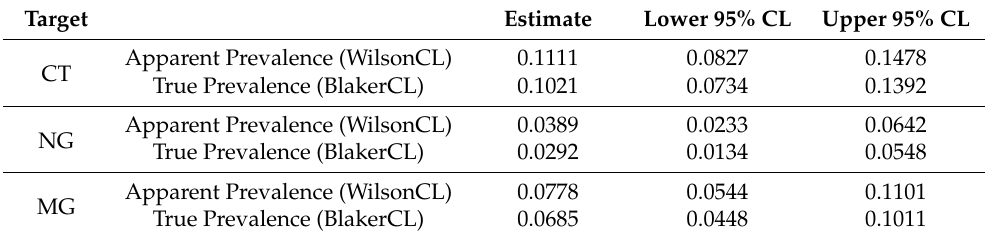
Table 4. Estimated true prevalence in this study with Rogan–Gladen